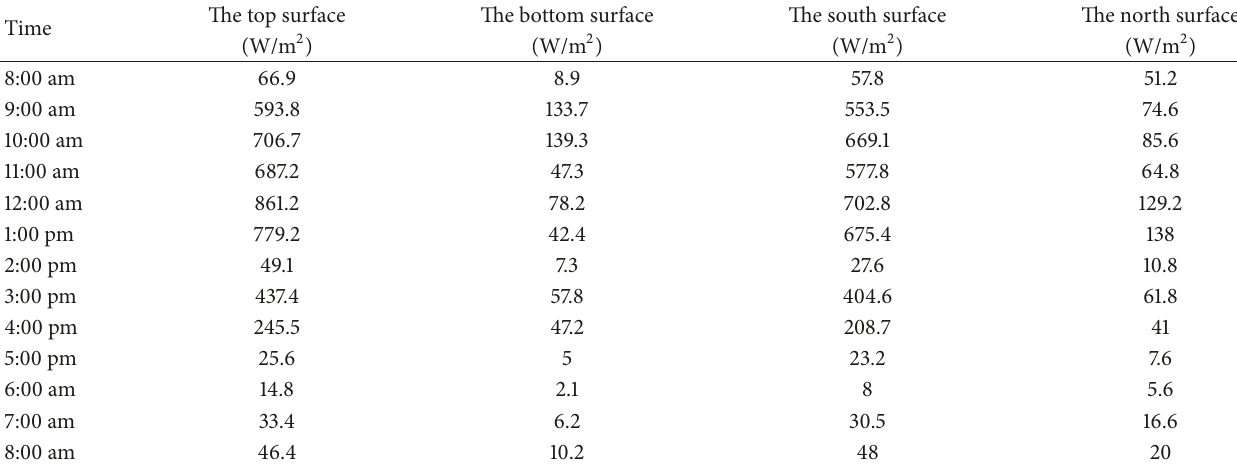
Table 1: Solar intensity at different positions and times.